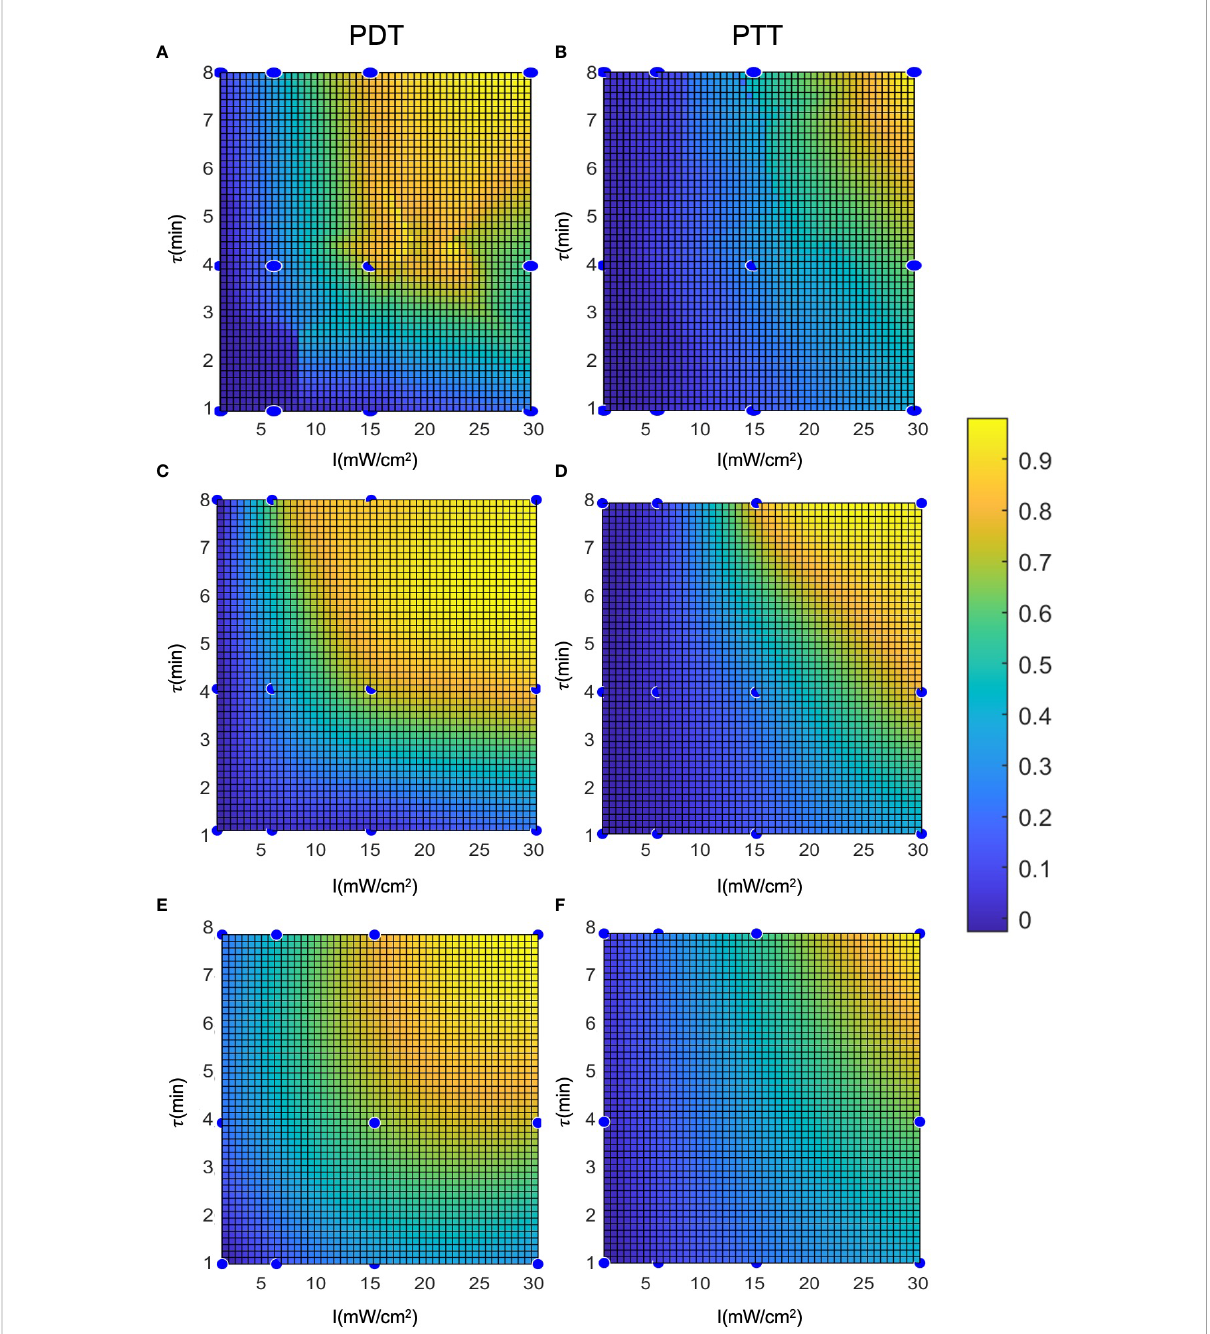
FIGURE 8 Representation of the cell death rate in two dimensions: (A, B) LOWESS regression, (C, D) interpolation, (E, F) analytical